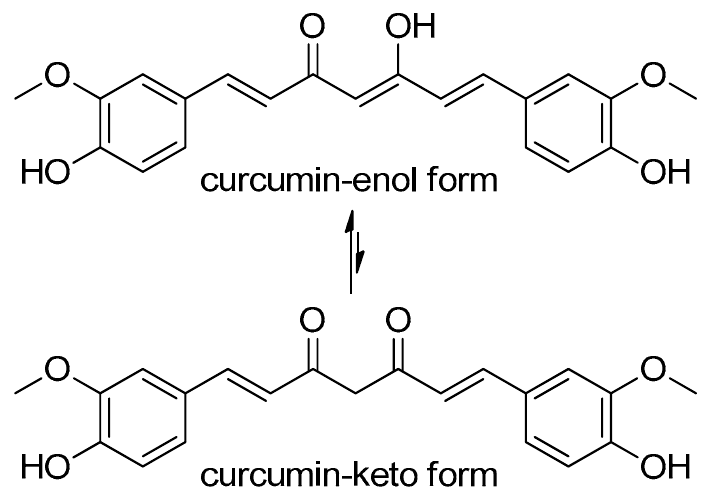
Figure 1. Chemical structure of curcumin in its enol and keto forms.